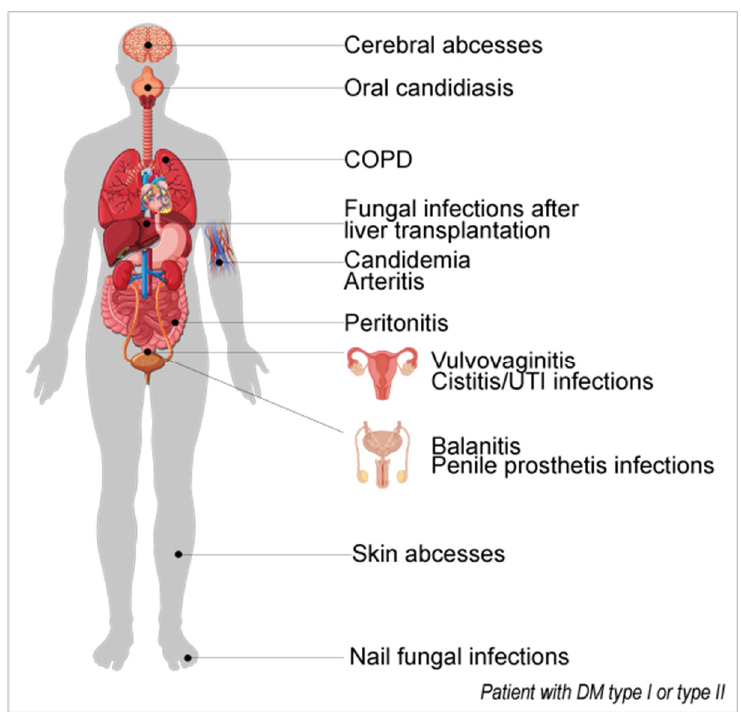
Figure 1. Main diseases related to Candida sp. occurring with higher incidence in patients with diabetes mellitus type 1 or type 2 (adapted image from GraphicsRF on stock.adobe.com).